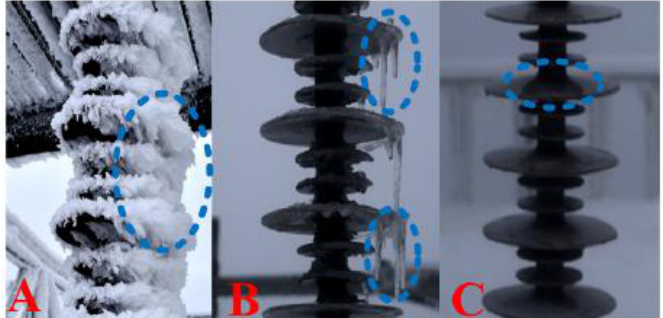
Figure 10. Iced insulators with various types of ice coverage, such as ( a ) rime rice (at below 0 °C), ( b ) glazed-ice (at below 0 °C) and ( c ) continuous water film due to loss of hydrophobicity (at above 0 °C) [6].